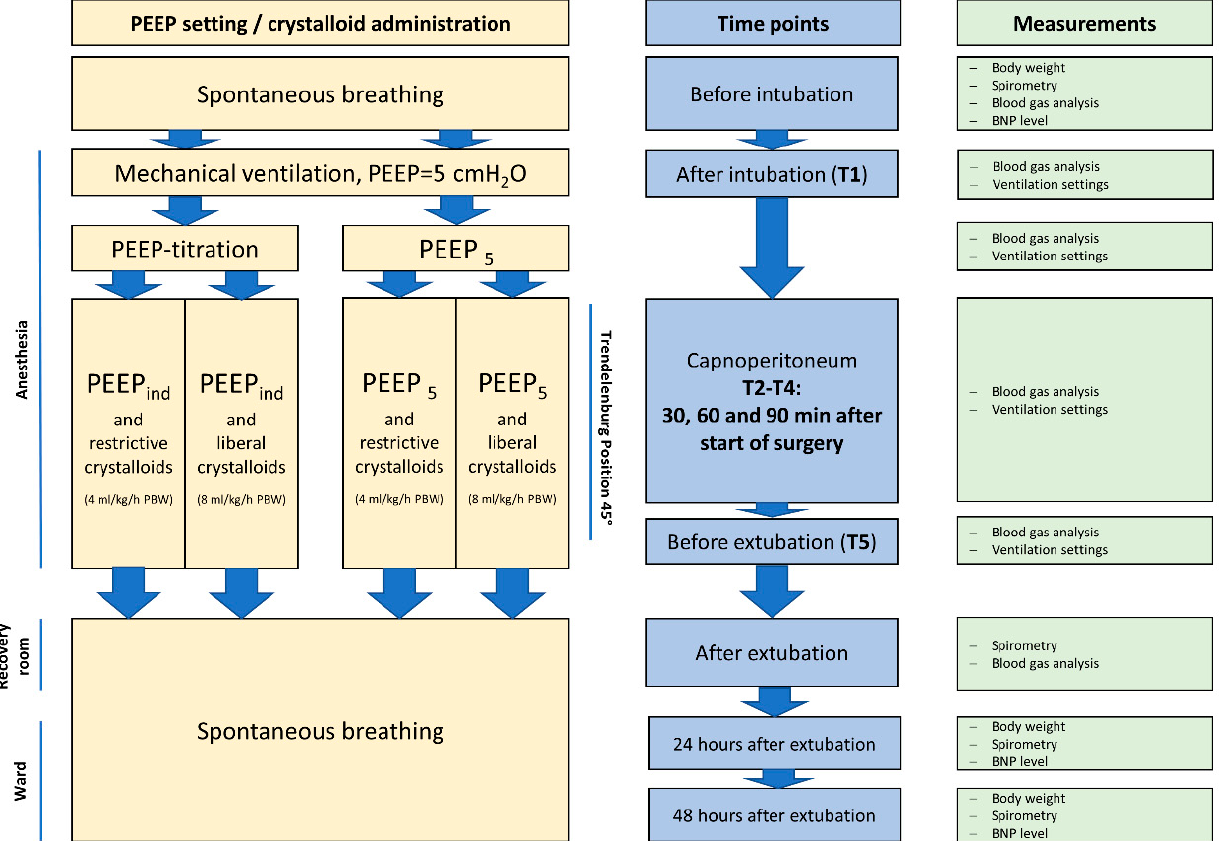
Figure 1. Schematic diagram of the protocol and interventions for the study groups.